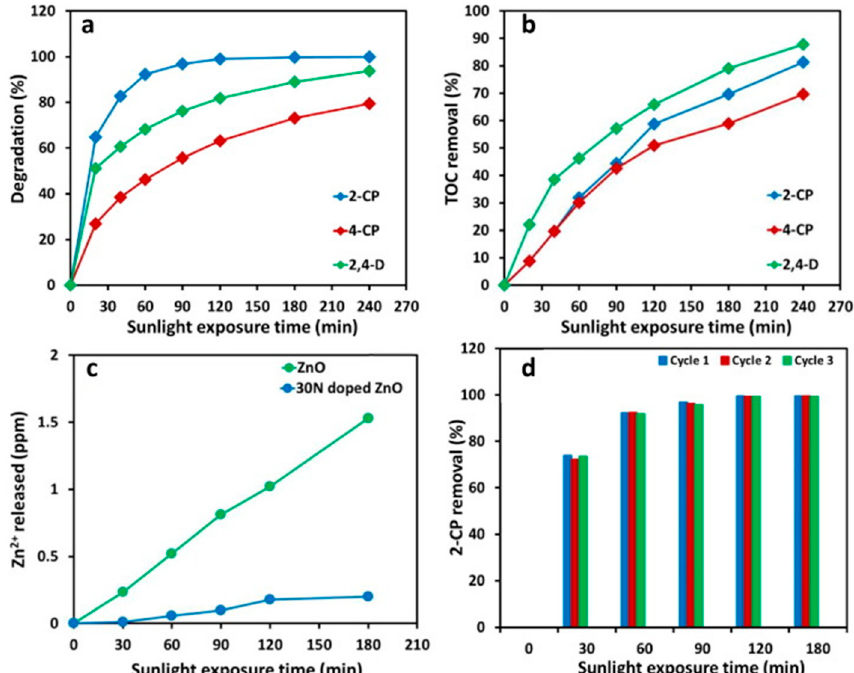
Figure 4. ( a ) The degradation and ( b ) mineralization of N-doped ZnO films for 2-CP, 4-CP, and 2,4-D. ( c ) The stability of pristine ZnO and N-doped ZnO film. ( d ) The stability and reusability of an N-doped ZnO film for the degradation of 2-CP. Adapted with permission from Reference [45]. Copyright (2016) Elsevier.